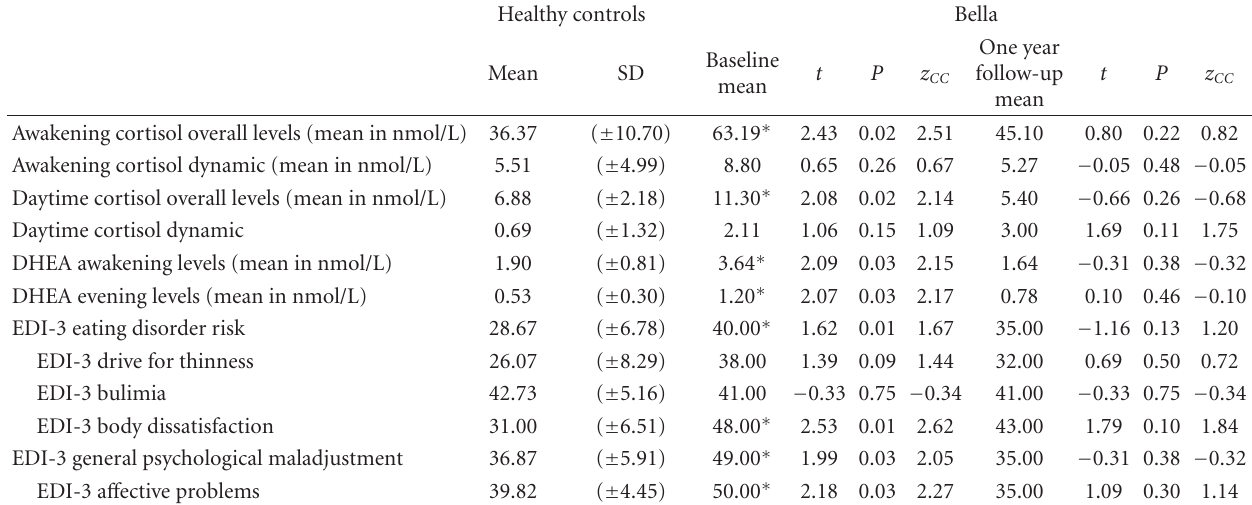
Awakening cortisol overall levels (mean in nmol/L) 36.37